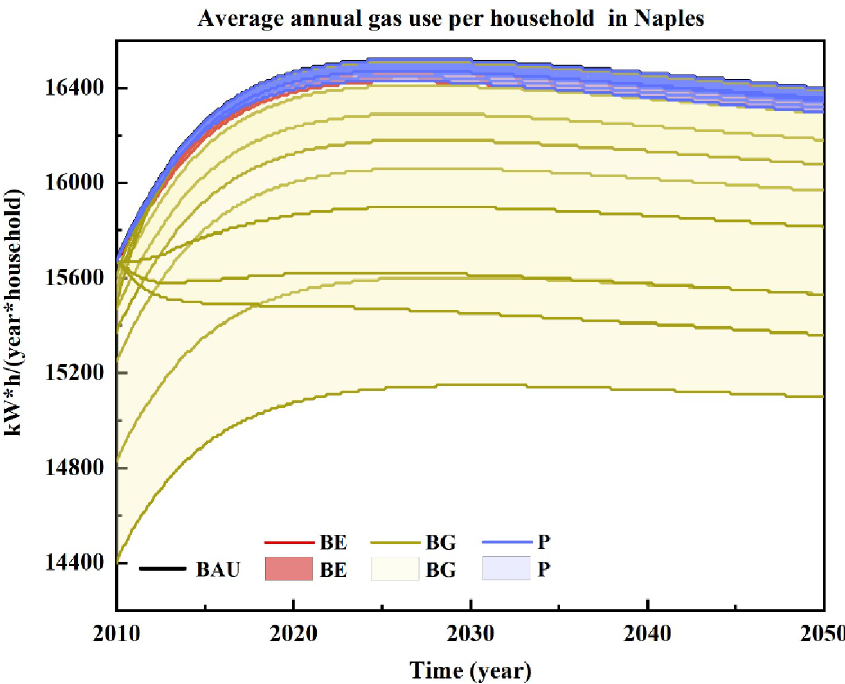
Fig 3. Scenarios for average annual household gas use in the metropolitan city of Naples for the years 2010–2050. Included scenarios: Business as usual (BAU), Price-based policies (P), Behavioural education actions (BE), and Behavioural guidance actions